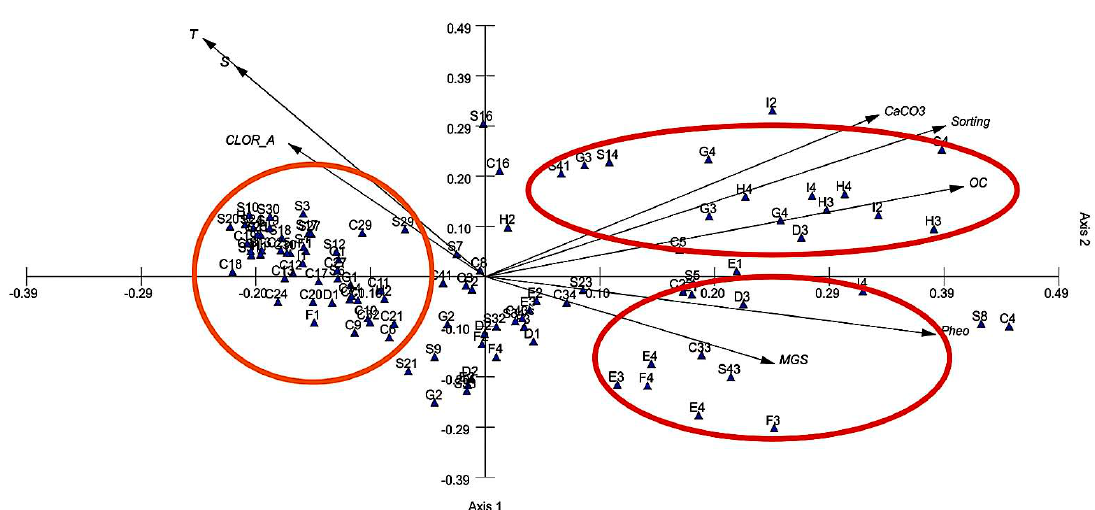
Fig. 4. – The principal component analysis (PCA) for the environmental variables water temperature and salinity, and sediment parameters that included pheophytin (Pheo), chlorophyll a (Chl a ), organic carbon (OC), total carbonate (CaCO stations; red circles, deeper stations. Data from the 53 stations sampled during the rainy and dry periods of 2009 are shown on Appendix 1.